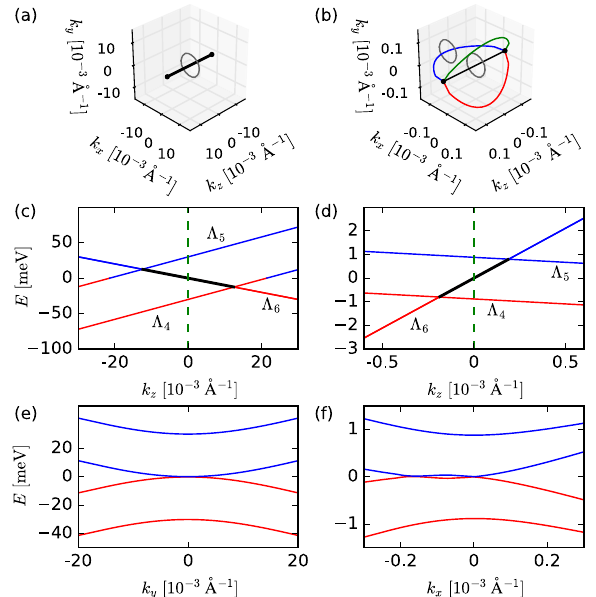
FIG. 1. Two types of triple point quasiparticles. (a) Type-A triple points are connected by a single nodal line, where conduction and valence bands are degenerate (shown in black). (b) Type-B triple points are accompanied by four such nodal lines, shown in black, green, blue, and red. The latter three occur in the mirror-symmetric planes in momentum space. The gray circles in (a) and (b) indicate paths for the Berry phase calculation. (c) [(d)] Band structure around a type-A [type-B] triple point along the C 3 axis. Here, Λ 6 represents the double degenerate band (double representation of C 3 ), while Λ 4 v ; 5 correspond to two one-dimensional representations. The black lines in (c) and (d) mark the region of the band structure that produces the nodal lines shown in black in (a) and (b). (e) [(f)] Band structure around a type-A [type-B] triple point in a mirror- symmetric plane orthogonal to k . The dashed green lines in (c) z and (d) mark the momentum k used in (e) and (f). Red (blue) in z (c) – (f) corresponds to occupied (unoccupied)